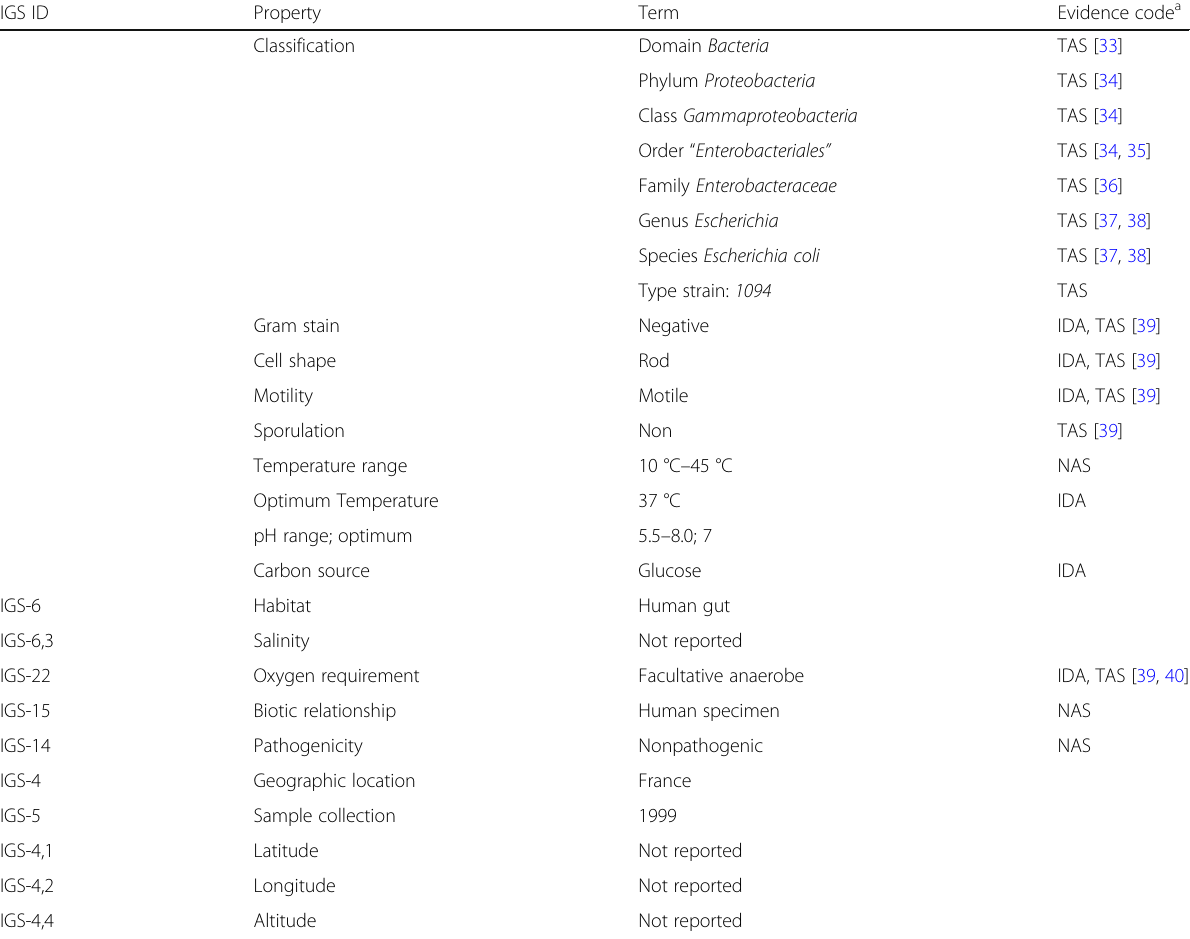
Table 1 Classification and general features of Escherichia coli strain 1094 MIGS